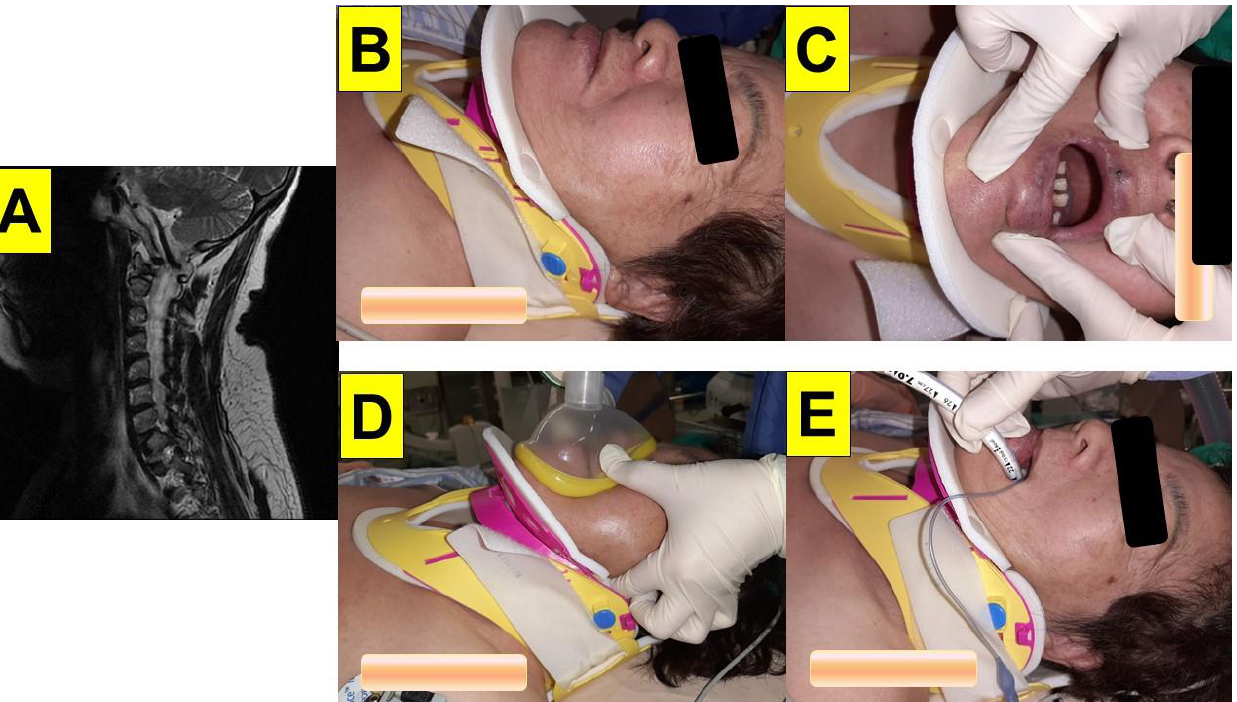
Figure 4. (Case 2) A 71-year-old woman with multiple trauma for emergency surgery. ( A ) Severe degenerative joint disease with neuroforaminal stenosis and spinal nerve root impingement at the